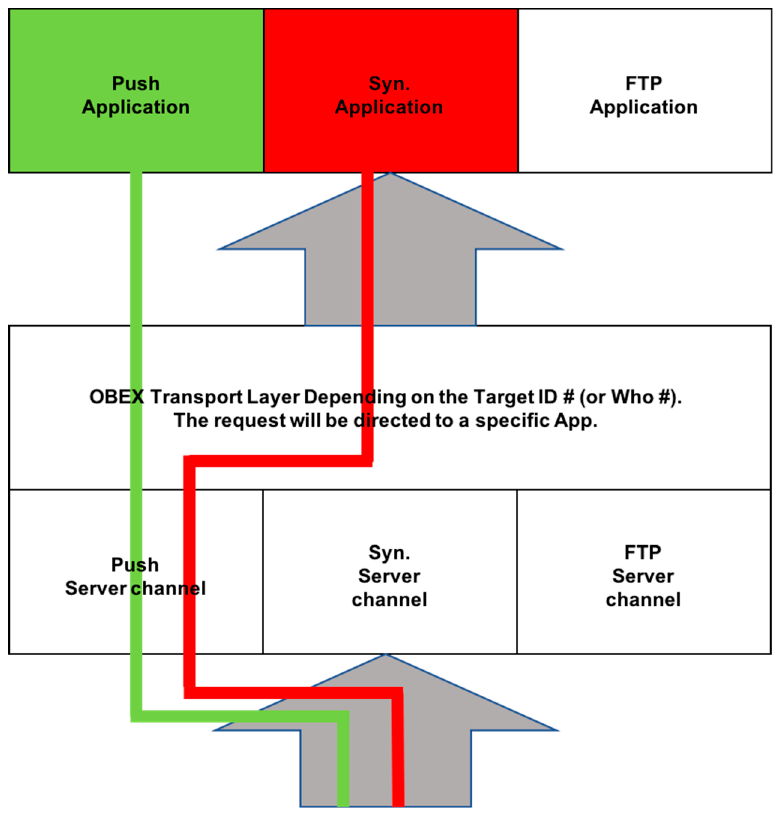
Figure 10. BlueSnarfing Attack.